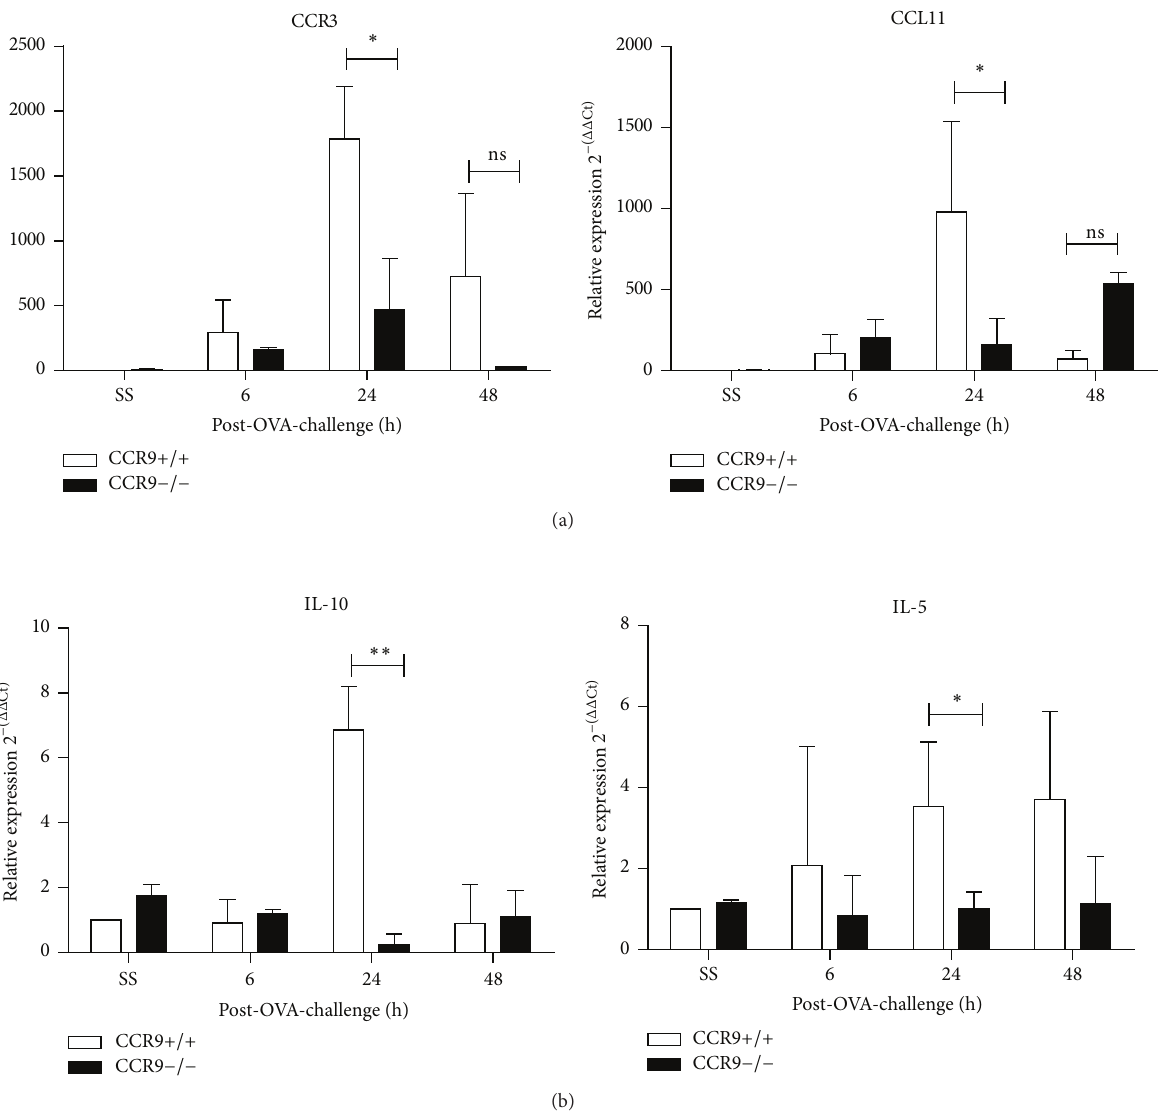
Figure 5: Gene expression of lung chemokine receptors and cytokines during OVA-induced inflammation in absence of CCR9. Expression of CCR3, CCL11, IL-5, and IL-10 in WT and CCR9 −/− mice was analyzed at 6, 24, and 48 h after OVA-stimulation. Data are representative of 3 independent experiments and represent mean ± SD. 𝑛 = 2 -3 for each group ( ∗ 𝑝 < 0.05 , ∗∗ 𝑝 < 0.01 when compared with WT mice or when compared each time with control